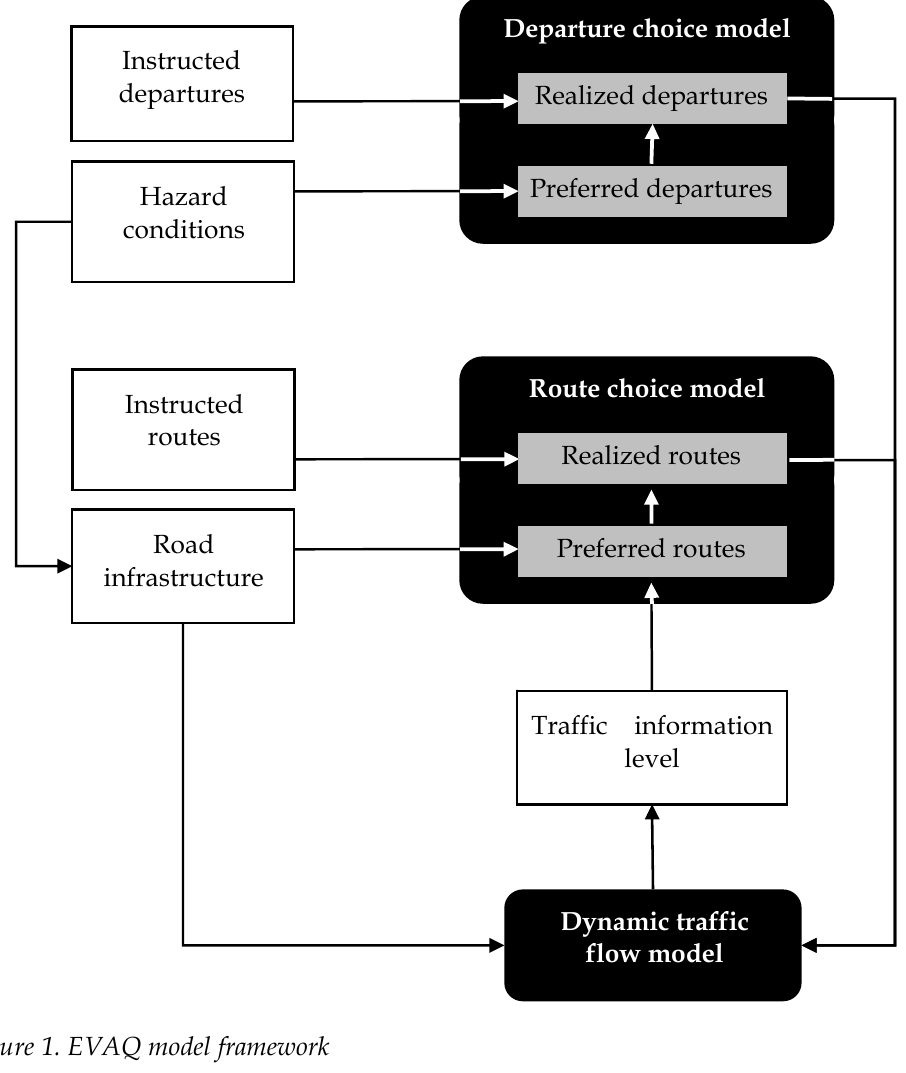
Figure 1. EVAQ model